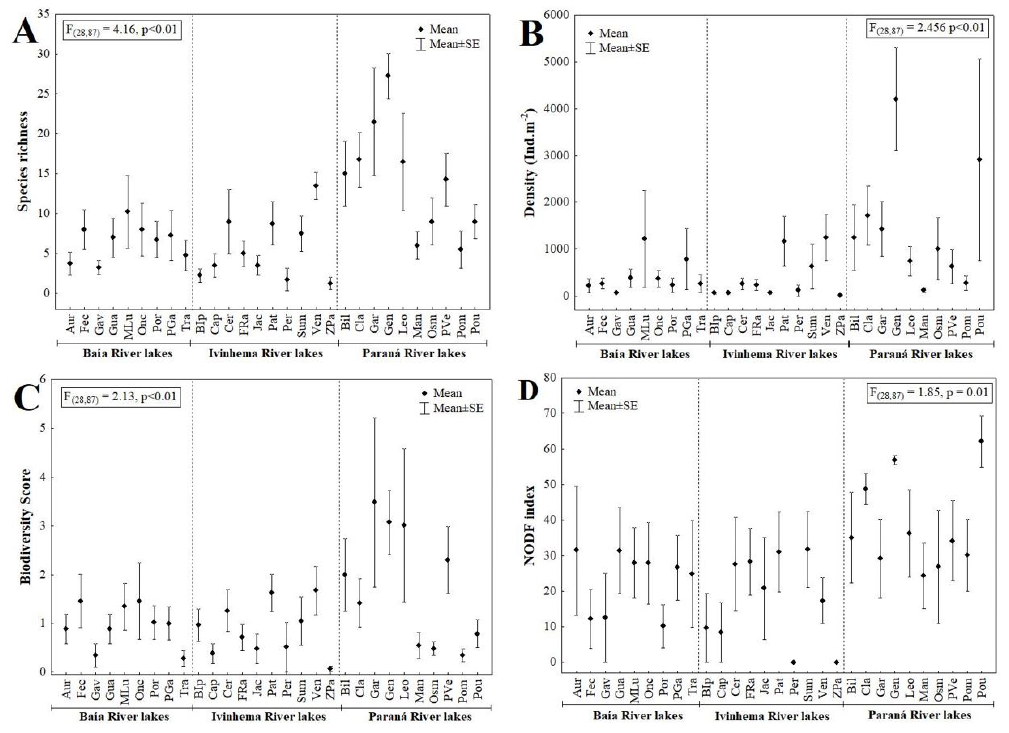
Figure 4. Variations in Chironomidae community in each floodplain lake according to the mean and standard error (SE) of (A) species richness; (B) density; (C) Biodiversity score; and (D) NODF index. Please vide Figure 1 for lakes name abbreviation.